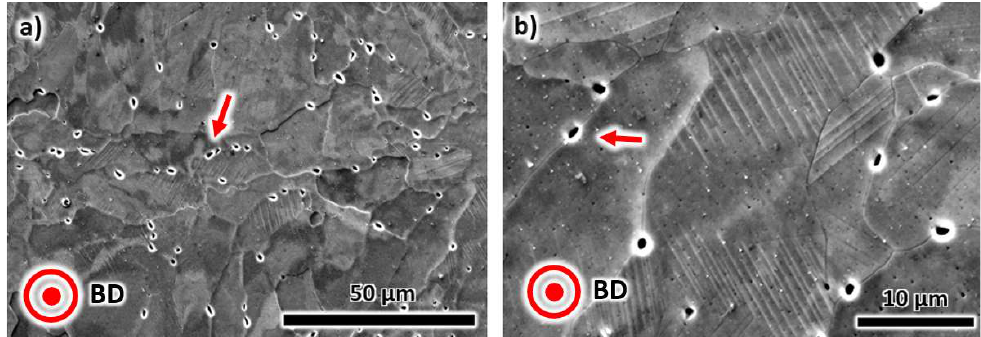
Figure 5. Scanning electron microscopy images of the heat-treated 316L sample taken from the plane normal to the building direction at ( a ) low magnification, and ( b ) high magnification.